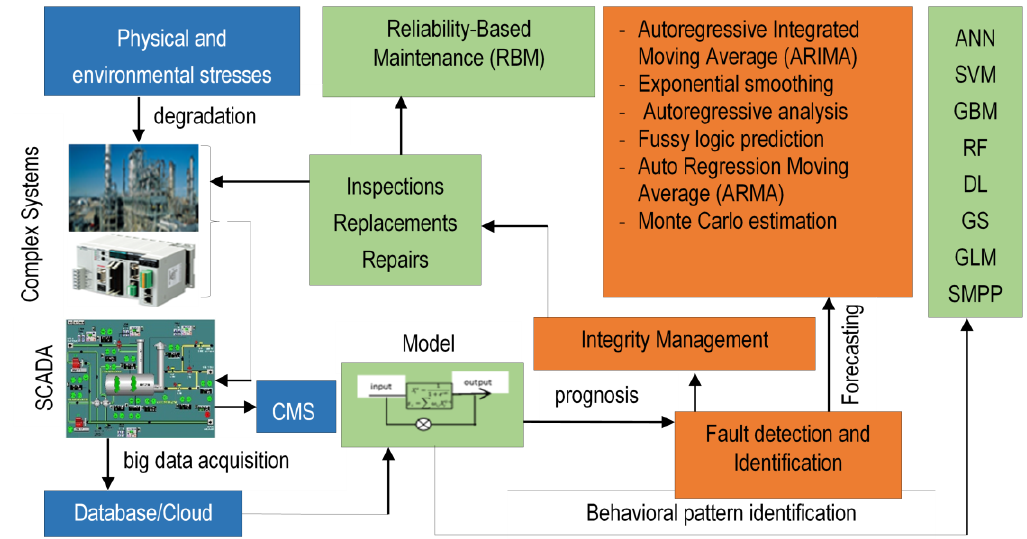
Figure 1. Framework for intelligent prognosis of complex systems (Note: SCADA, Supervisory Control And Data Acquisition; CMS, Condition Monitoring Sensor; ANN, Artificial Neural Network; SVM, Support Vector Machine; GBM, Gradient Boosting Machine; RF, Random Forest; DL, Deep Learning; GS, Grid Search; GLM, Generalized Linear Model; SMPP, Statistical Matching Performance